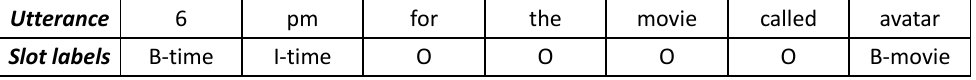
Figure 1. An example of slot filling in the movie